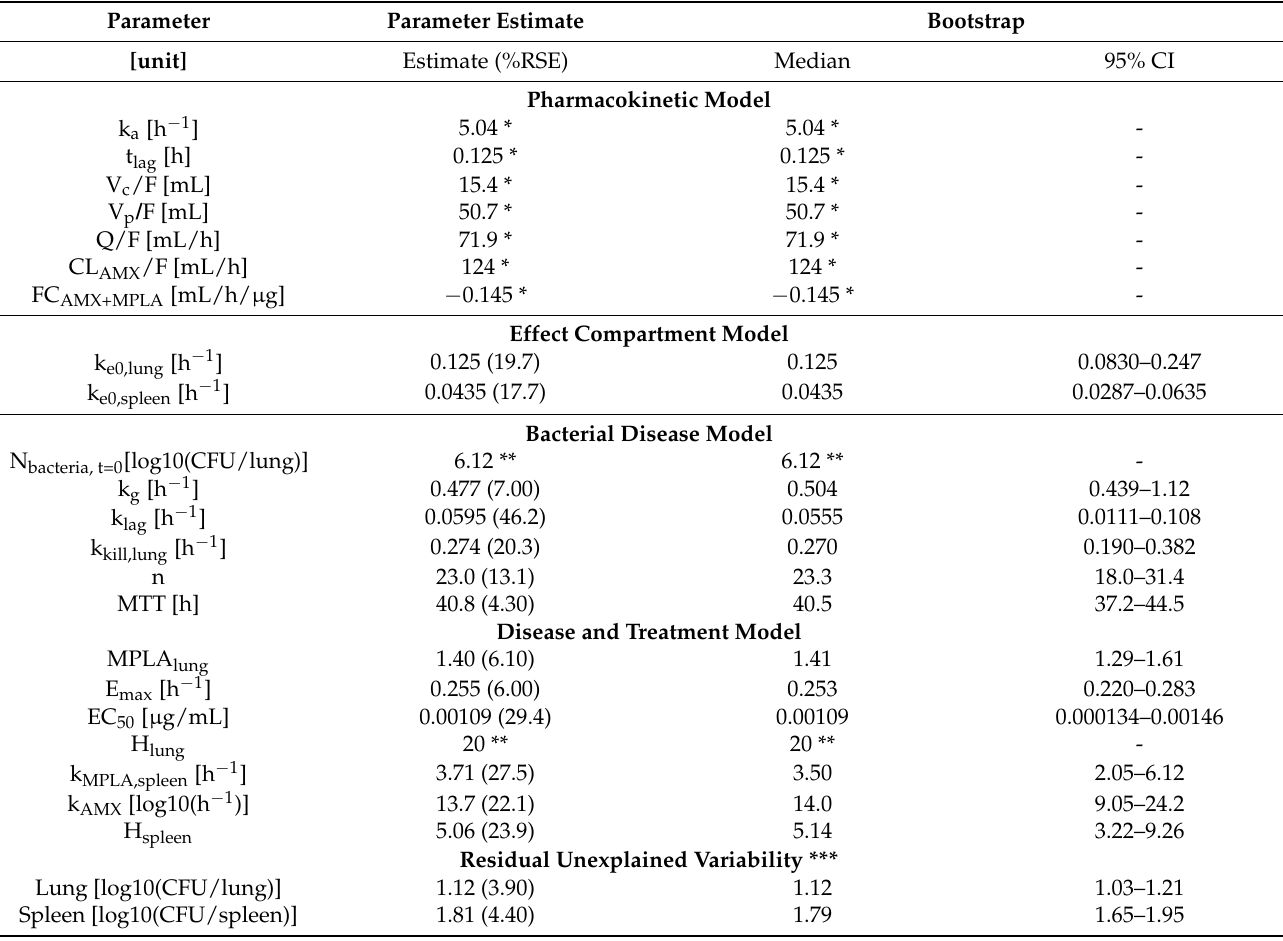
Table 1. Model-predicted parameter estimates including bootstrap results (convergence rate of 99.7%) of a sequential analysis of the pharmacometric pharmacokinetic/pharmacodynamic model of amoxicillin and monophosphoryl lipid